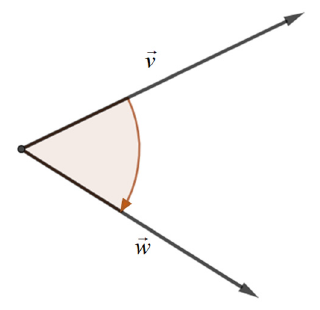
Figure 14. Angle between two vectors.